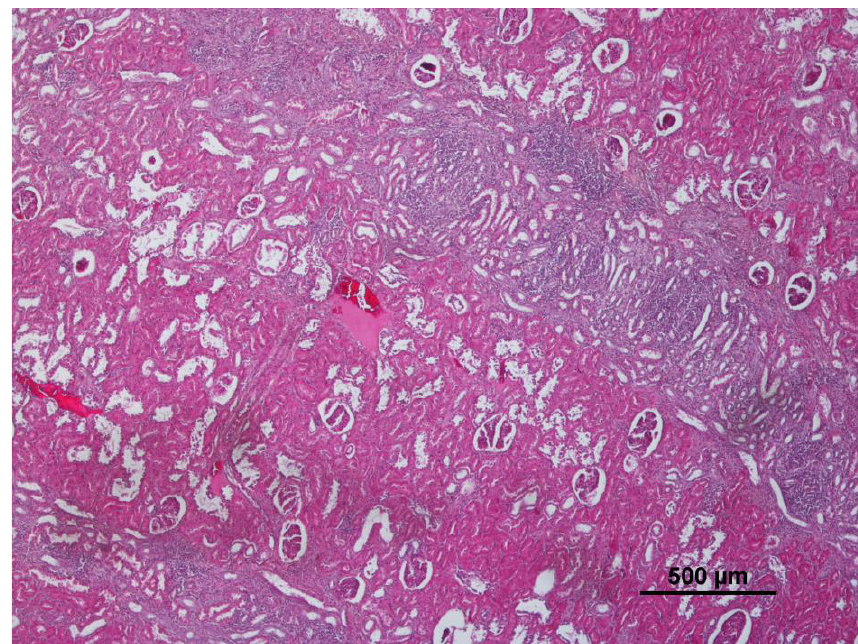
Figure 3. Interstitial nephritis detected in the kidney (10×,